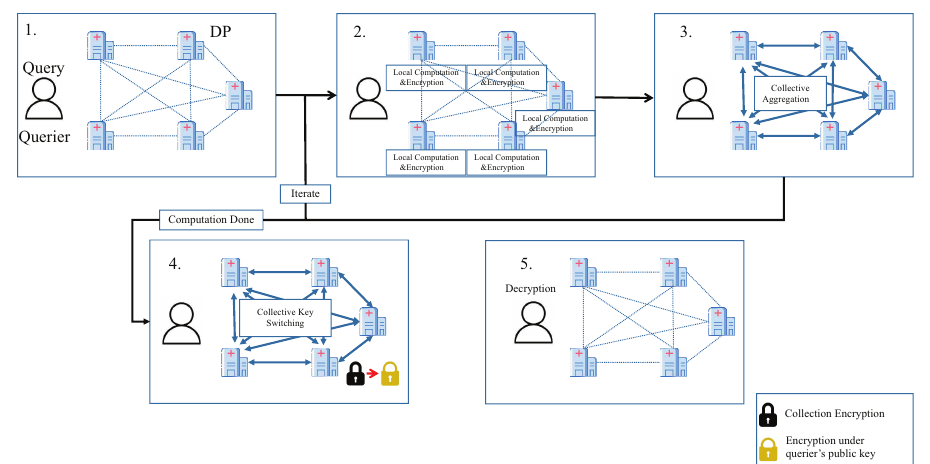
Figure 3. Application of MKFHE on medical.